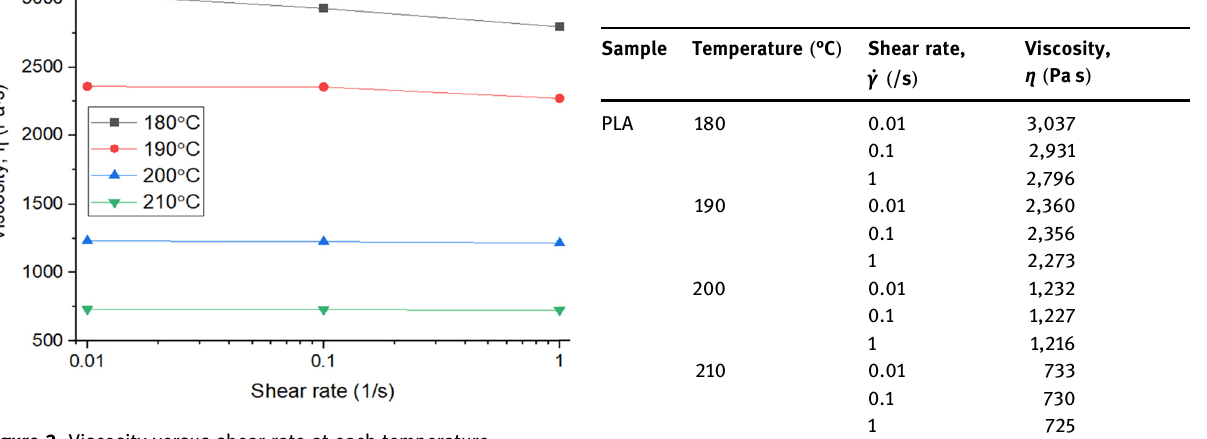
Figure 2: Viscosity versus shear rate at each temperature.